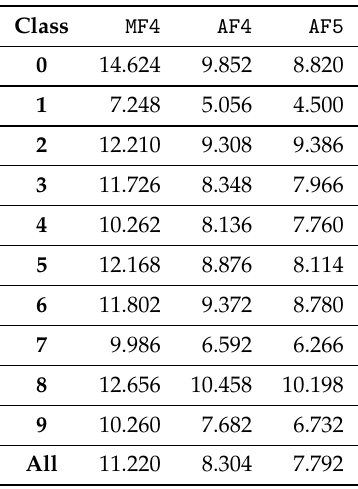
Table 5. The autoencoder errors, measured in terms of the Euclidean loss function, were calculated for all the proposed network architectures. In addition to the general error on the test set from the MNIST data set [7], specific values were calculated for each class separately. Thus, it was possible to evaluate how well the selected visual features described each of the